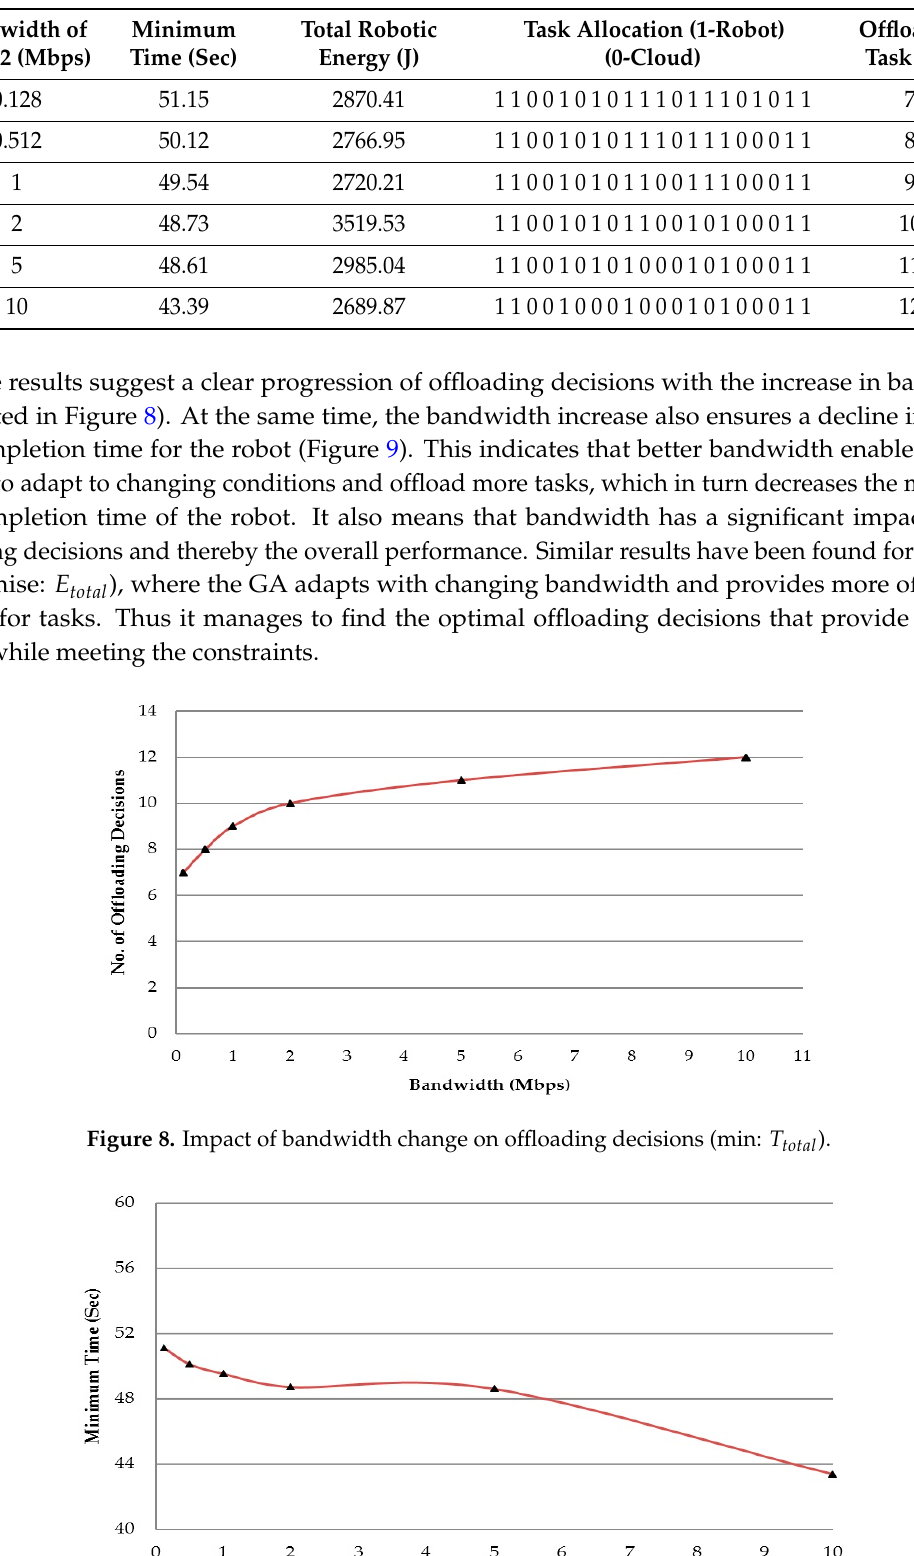
Figure 9. Impact of bandwidth change on minimum task completion time (min: (cid:1846) (cid:3047)(cid:3042)(cid:3047)(cid:3028)(cid:3039) ).